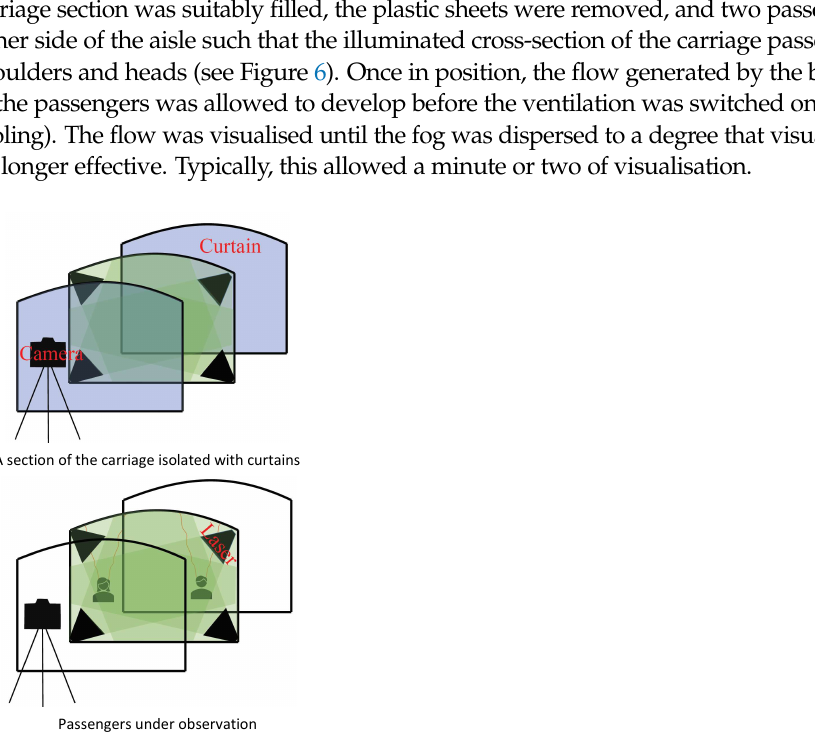
Figure 6. Schematic of the flow visualisation setup. A 2 m long section of the carriage was isolated using curtains and filled with inert smoke. Once the section was filled with smoke, the curtains were removed, allowing passengers to enter the section and sit across the aisle from each other on seats illuminated with laser lights. The body heat of the passengers produce thermal plumes, andventilation was subsequently switched on. Cameras were used to record the movement of the tracer smoke along with the dominant